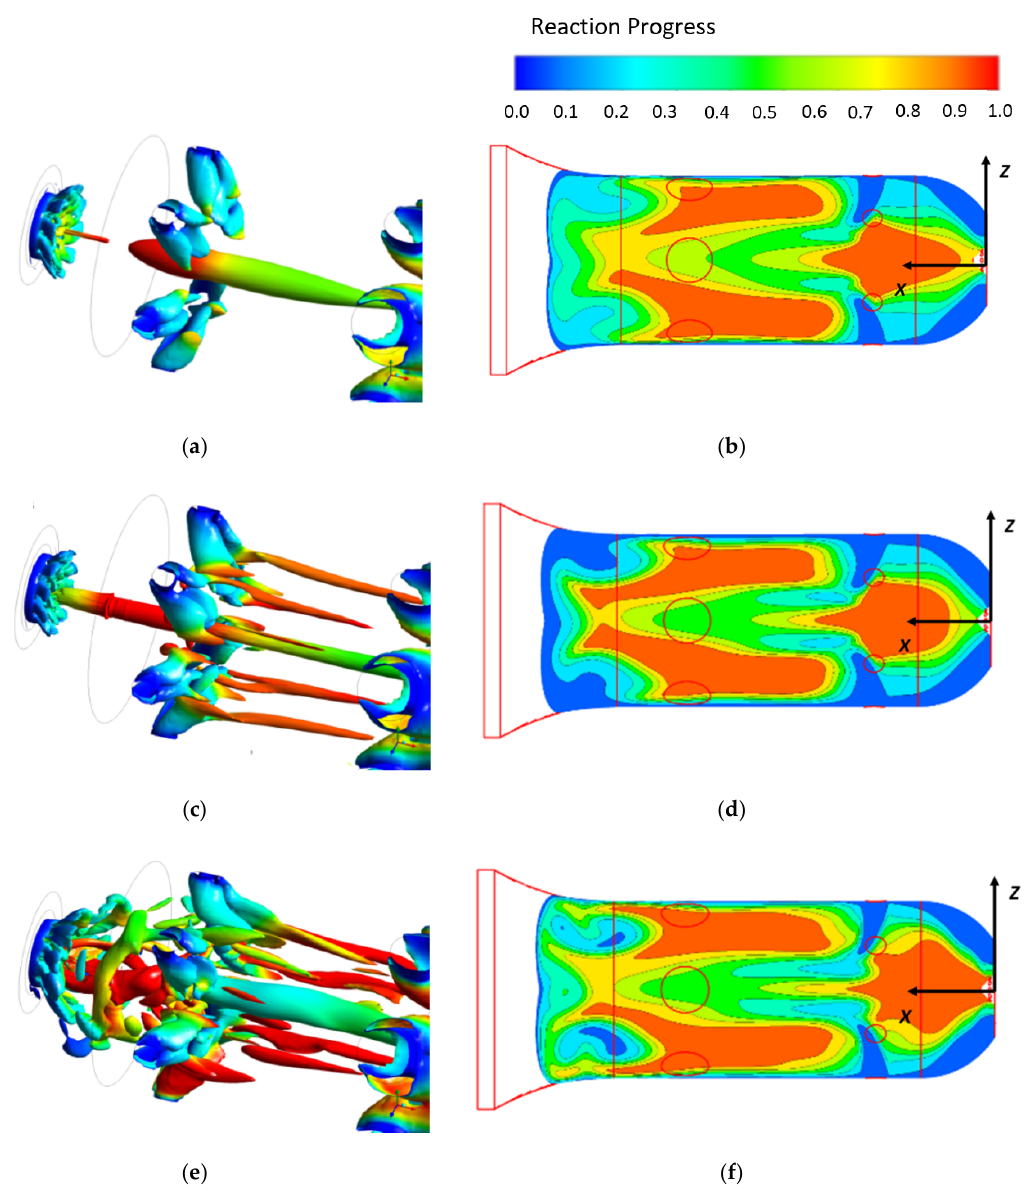
Figure 2. Instantaneous contour plots of a typical swirling strength equal to 2222.24 / s (Left column) and the time-averaged reaction progress (right column). ( a , b ) SSTKW, ( c , d ) RSM. ( e , f ) SSTKWSAS.